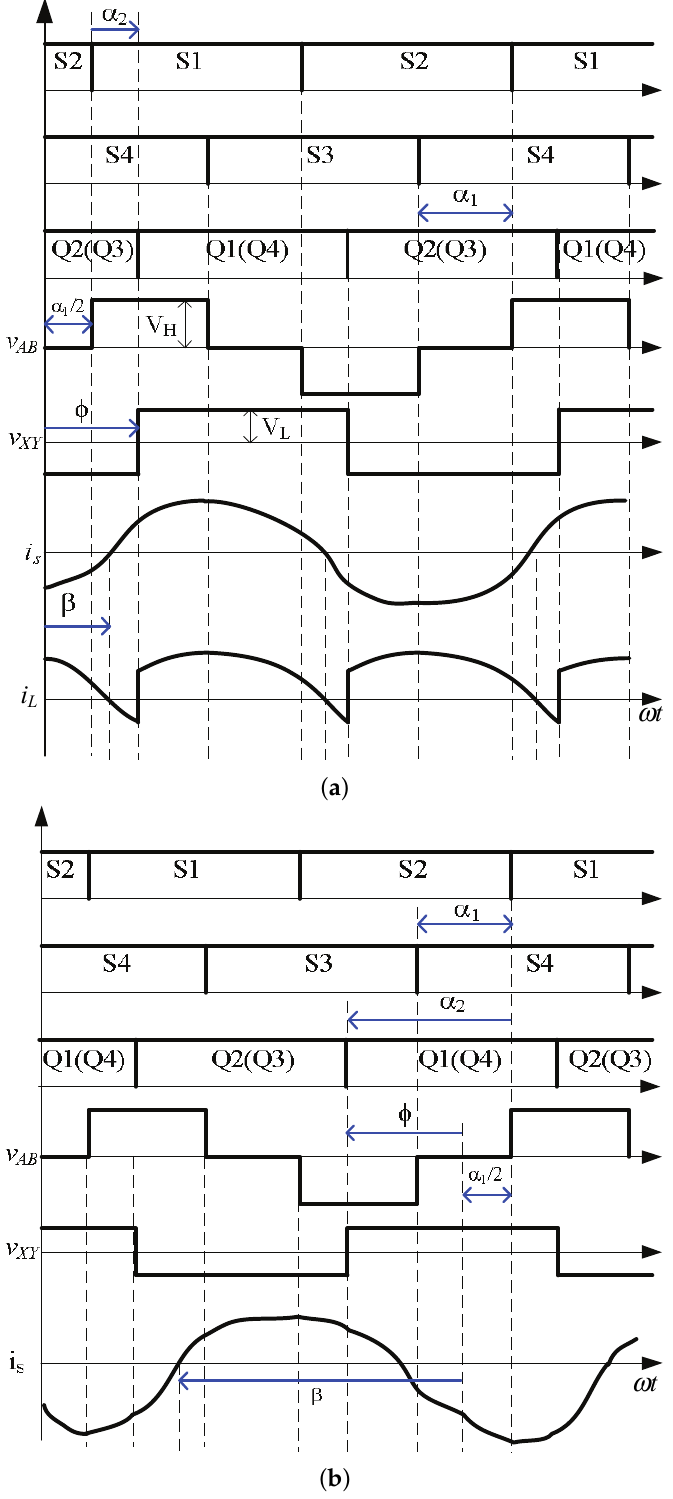
Figure 3. Typical steady-state waveforms of a dual-bridge series resonant converter (DBSRC) with dual-phase-shift (DPS) control for ( a ) positive power and ( b ) negative power